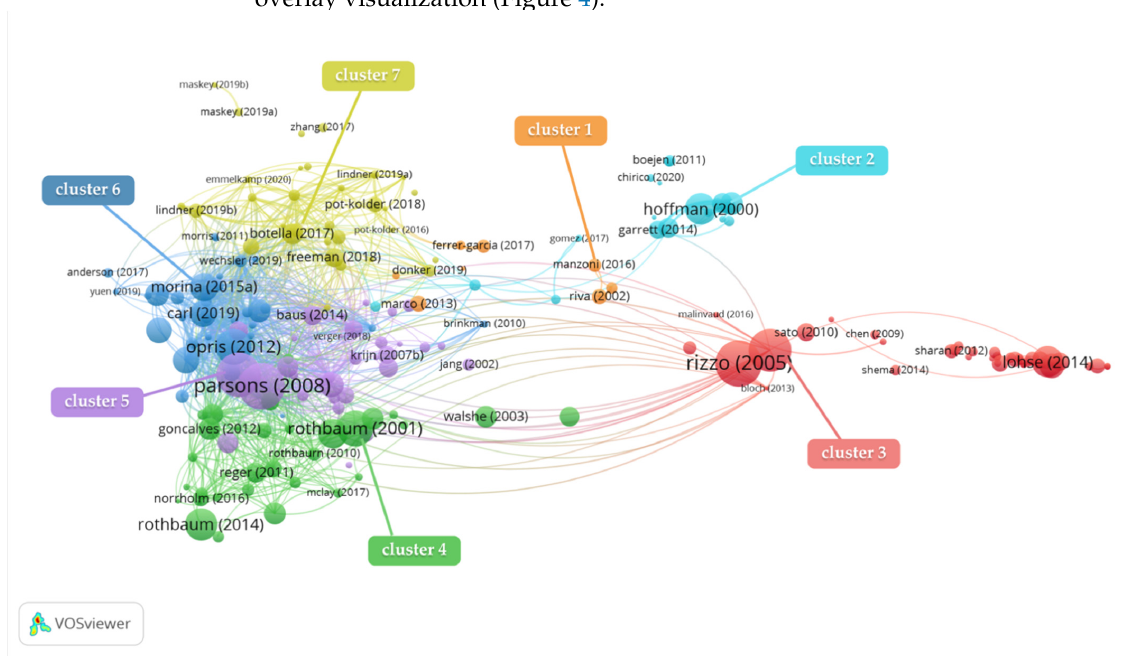
Figure 2. Network visualization of bibliographic coupling analysis of the theme of virtual reality (VR) and therapy in the Web of Science core collection (WoSc) database via VOSviewer (devised and generated by the authors).